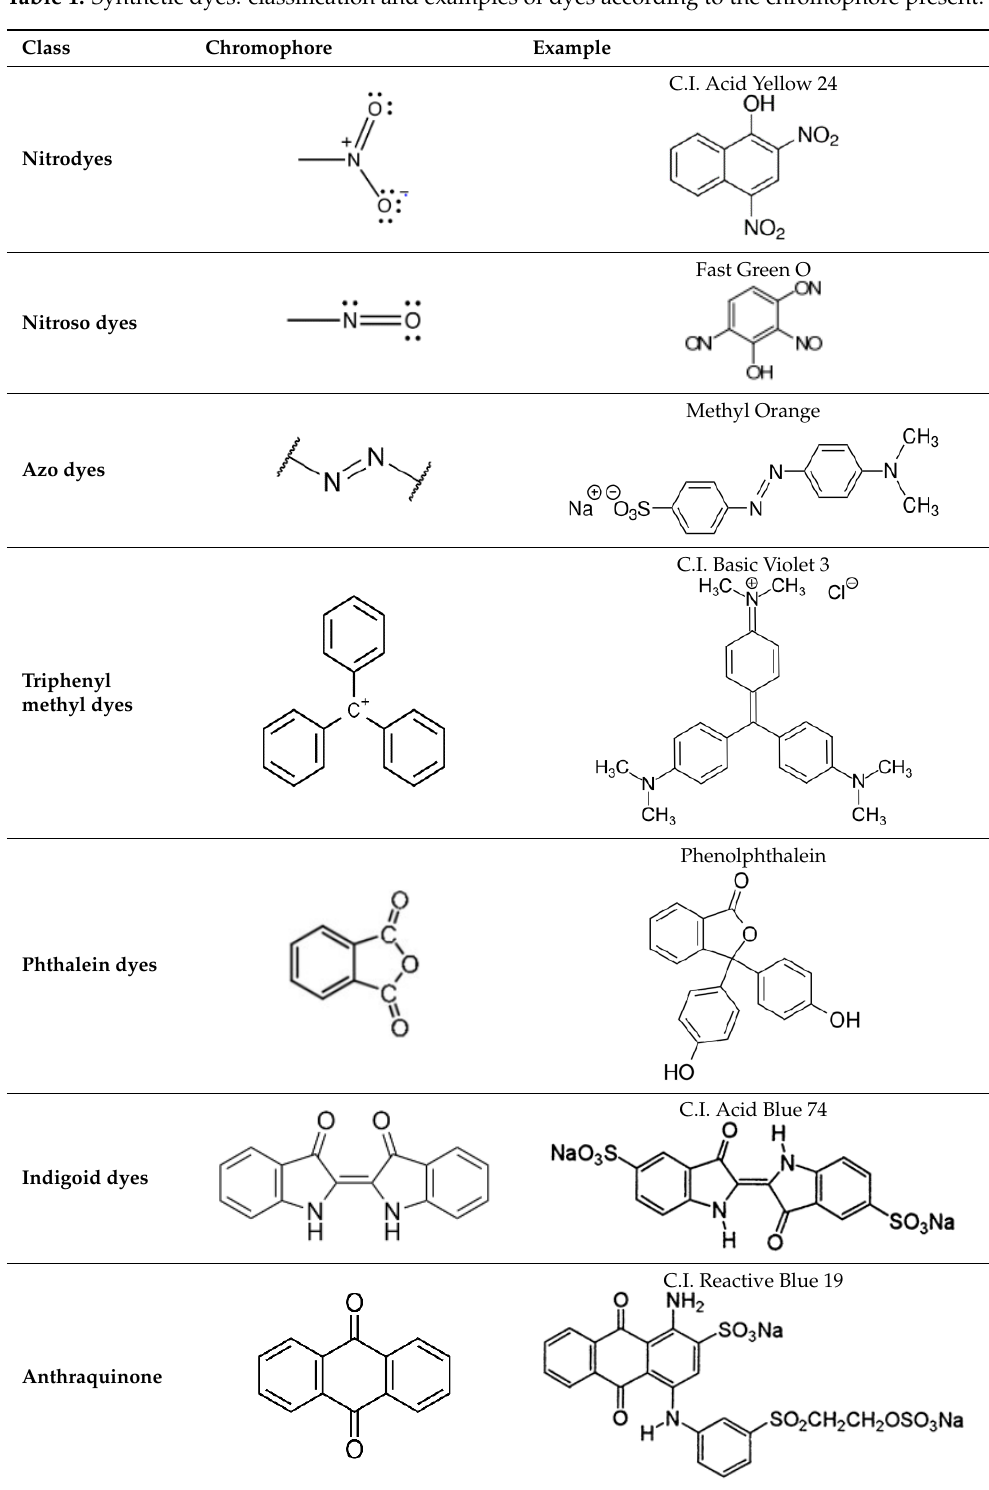
Table 1. Synthetic dyes: classification and examples of dyes according to the chromophore present.